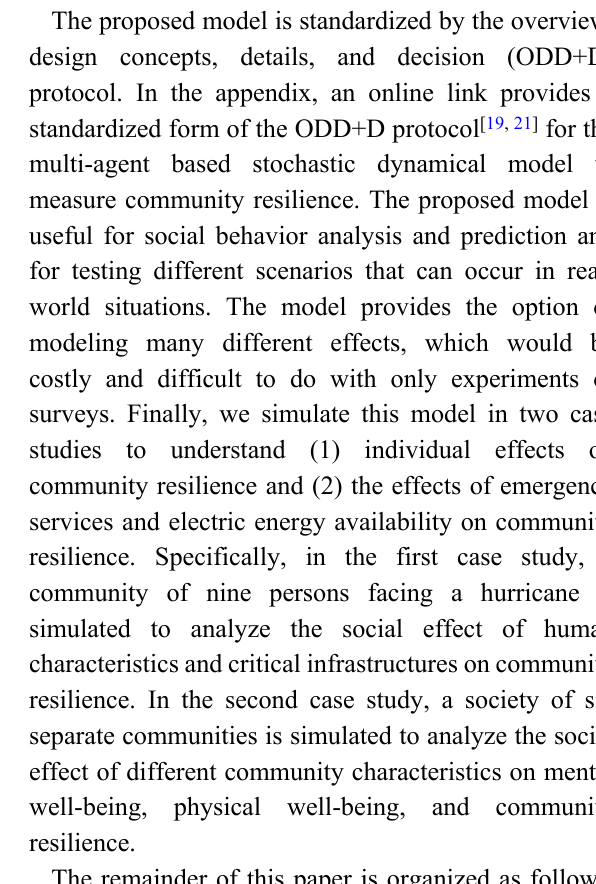
Fig. 1 Artificial society including agents and external factors, i.e., critical infrastructures, power systems, emergency services, and mass media. Critical infrastructures influence both mental and physical well-being while mass media only affects the mental